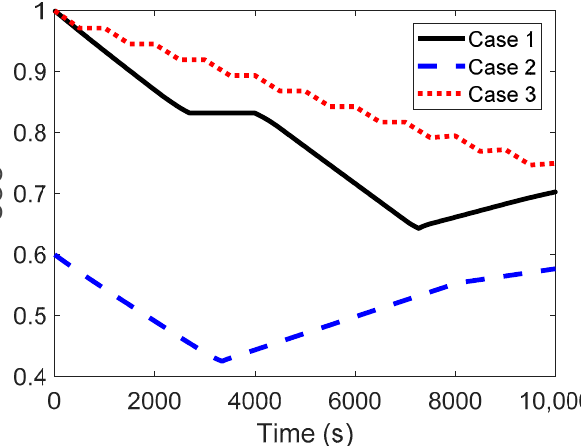
Figure 6. The state of charge (SOC) of the considered battery in the suggested integrated system for the UAV.